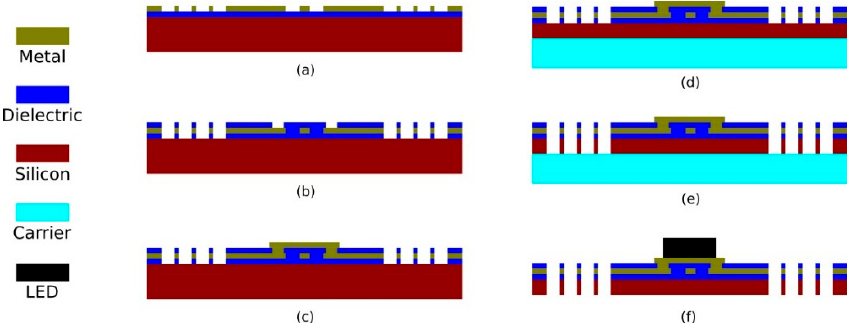
Figure 2. Overview of the proposed process ( a ) Si oxidation together with first metal layer deposition and patterning; ( b ) Inter-layer dielectric deposition and patterning; ( c ) Second metal layer deposition and patterning; ( d ) Wafer thinning and carrier mount; ( e ) DRIE; ( f ) SMD LED soldering and carrier